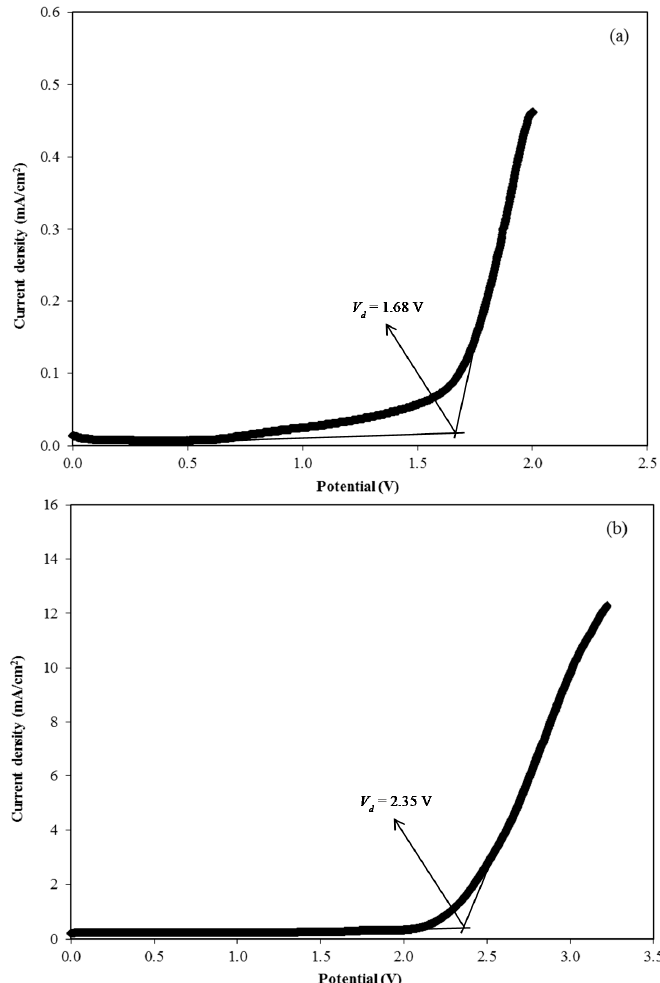
Figure 4. Linear sweep voltammetry (LSV) curve for the ( a ) CSNHG4 electrolyte and ( b ) CSNHG5 electrolyte.